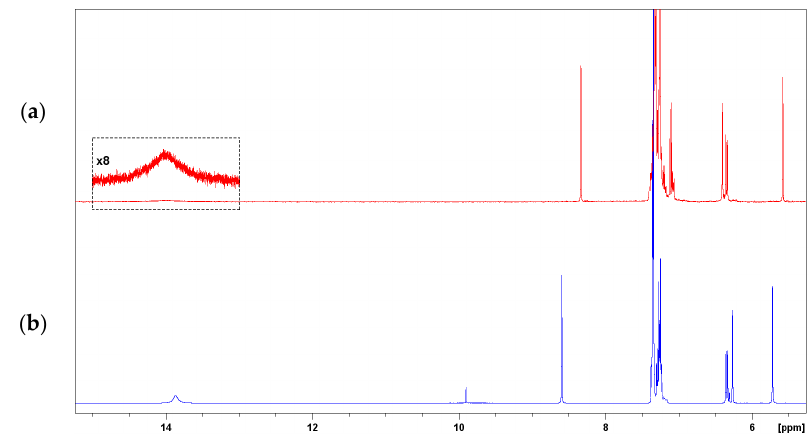
Figure D2. 1 H-NMR spectra of mOHsaladpm in ( a ) CDCl 3 and ( b ) DMSO-d 6 .